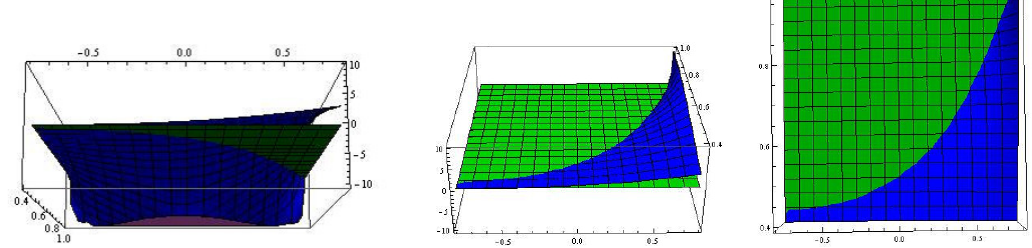
Figure 2. The locus of ( φ , s ) which satisfies (6) (the intersection curve of the green domain and the blue